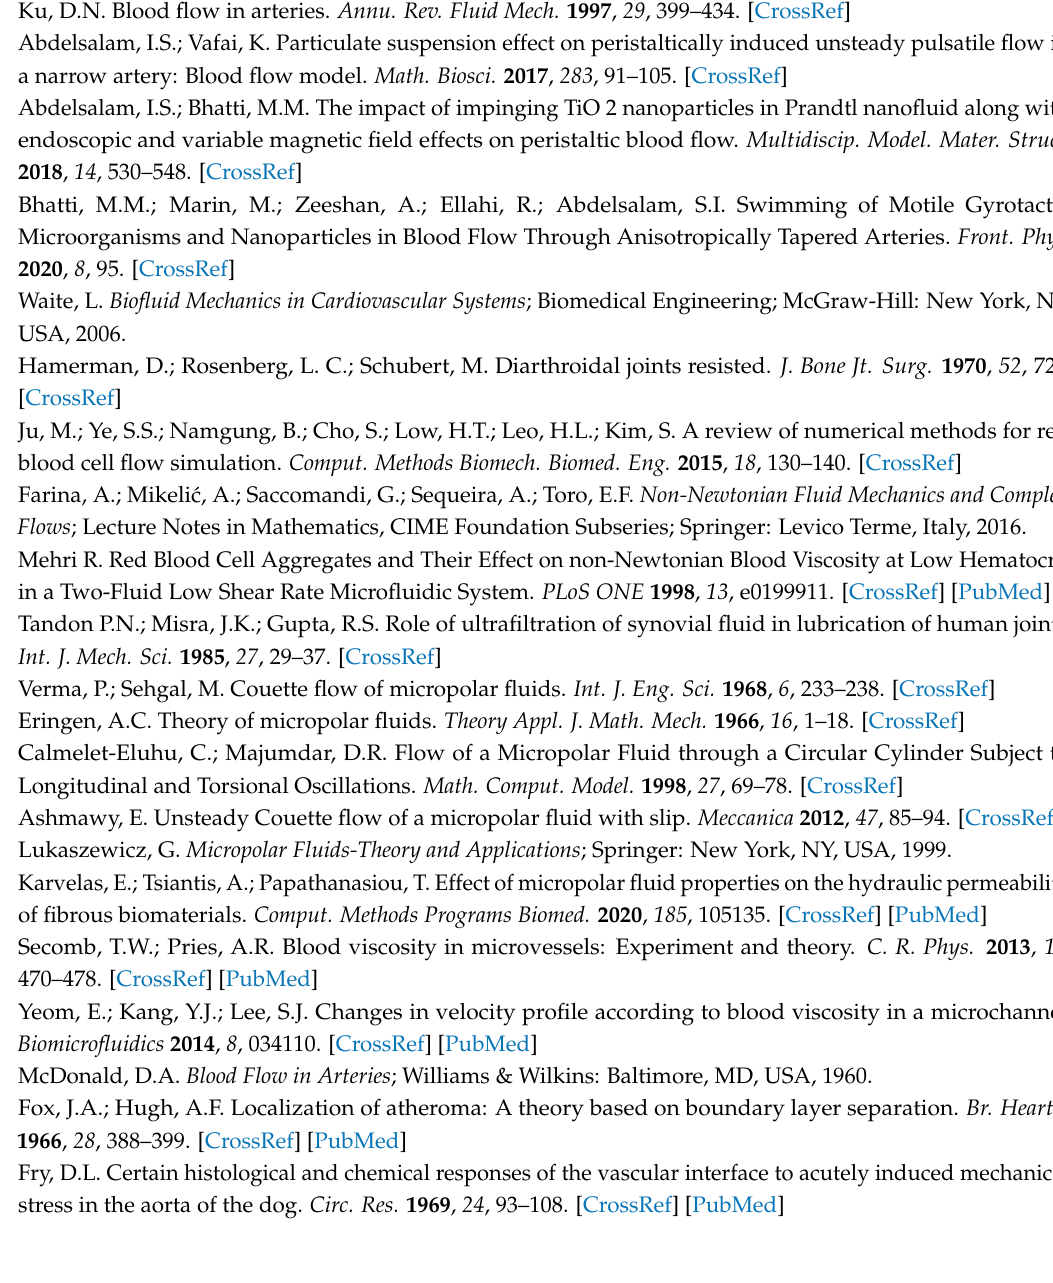
Non dimensional pressure - ∆ U Percentage difference between micropolar and Newtonian velocities - ∆ τ w Percentage difference between micropolar and Newtonian shear stresses - ∆Ω Percentage difference between the base micropolar case ( m = 0.1 ) and the cases with higher - h width